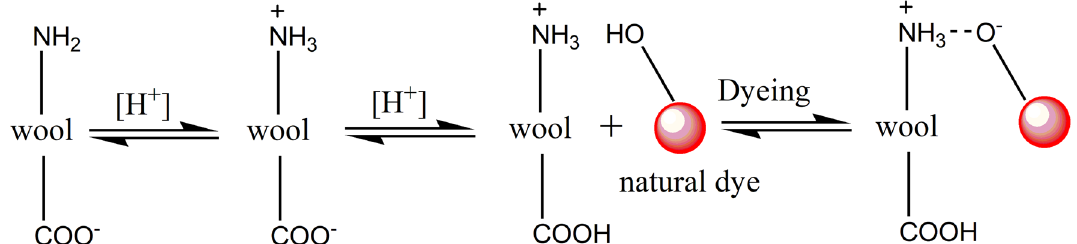
Figure 8. Mechanism of wool dyeing with natural dye in acidic conditions.